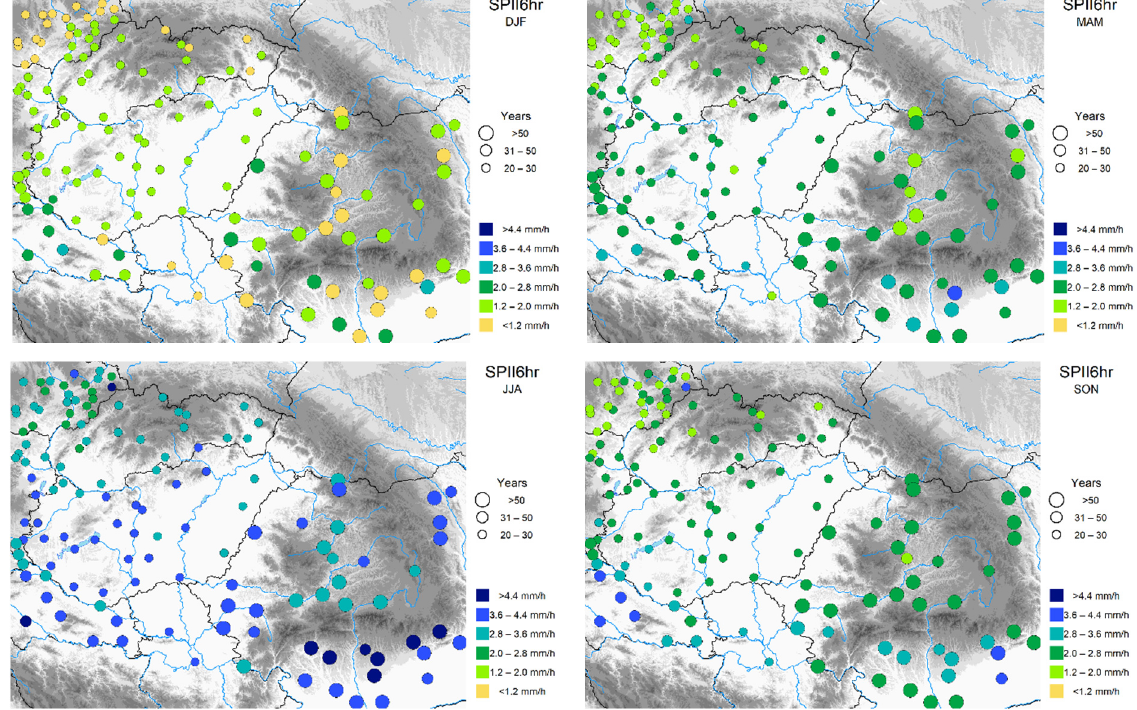
Figure 8. Seasonal averages of the 6h precipitation intensity (SPII6hr). The circles and their sizes are the same as in Figure 3.